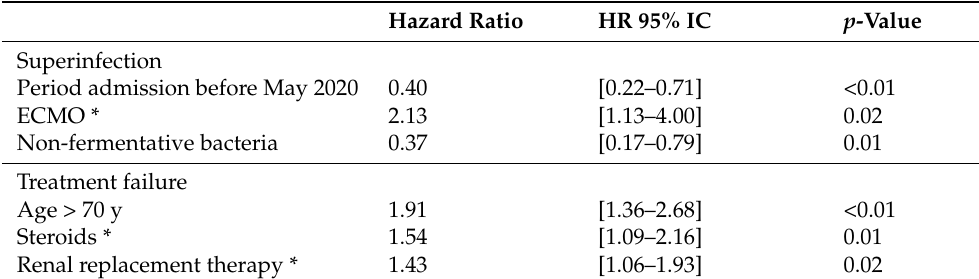
Table 5. Risks factors associated with superinfection and treatment failure (relapse, superinfection, or death) using a multivariable Fine and Gray competing risk